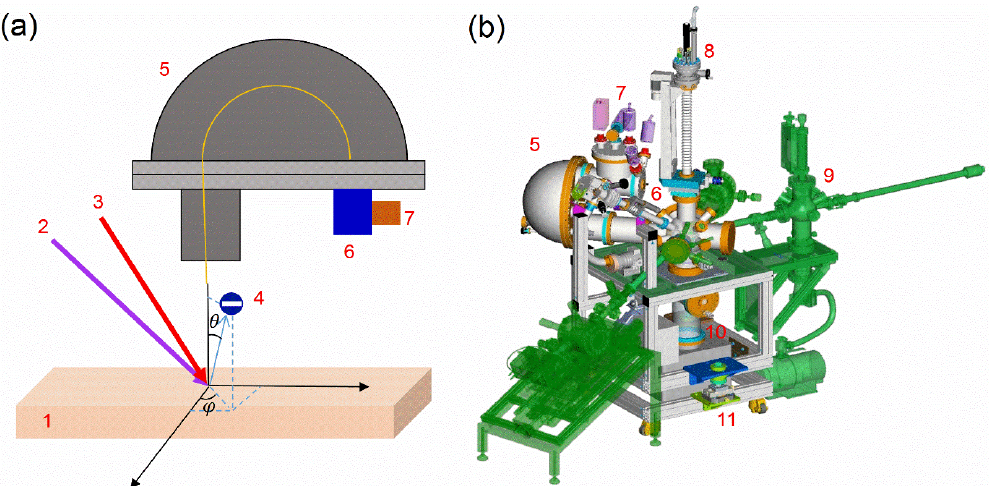
Figure 6. Angle Resolved Photo-emission Spectrometer (ARPES): ( a ) schematic and ( b ) engineering drawing. (1) sample material to be analyzed; (2) EUV pulse; (3) excitation laser pulse (ELP); (4) photo-electron (PE); (5) Hemispherical electron analyzer; (6) ARPES detector with multichannel plate (MCP), phosphor screen, telescope and CCD camera; (7) Spin-spectrometer with Mott spin detector; (8) sample material manipulator with five axes and liquid He cooling; (9) load lock for inserting sample material into the ARPES chamber; (10) ultra-high vacuum (UHV) ion pump; (11) XYZ fine mechanical adjustment for positioning the center of the ARPES chamber exactly in the focal-point of the EUV toroidal mirror.